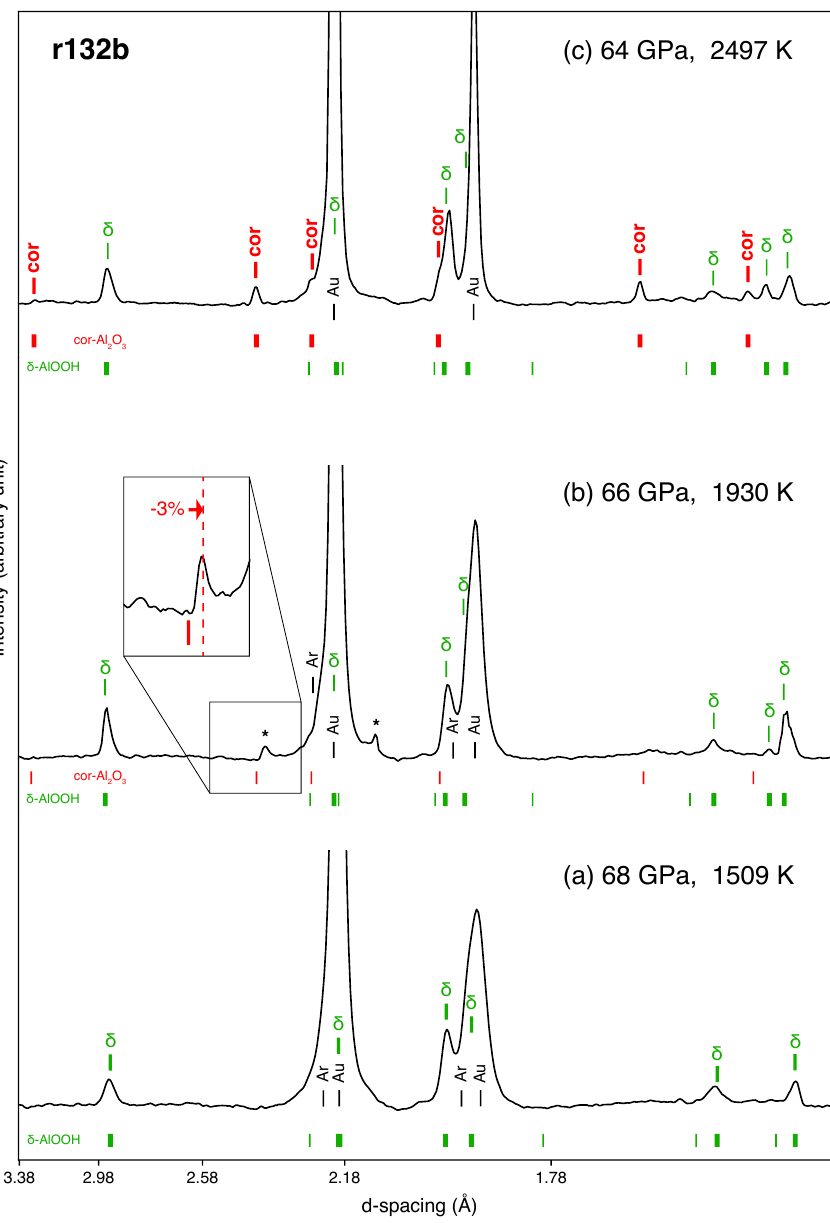
Figure 1. Dehydration of δ -AlOOH detected in XRD patterns for run#132b. ( a ) At 1509 K, only precursor materials (i.e., δ -AlOOH, Ar and Au) are present; ( b ) At 1930 K, two unknown peaks appear, one of which could belong to cor-Al 2 O 3 . However, as the inset shows, the unit-cell volume of cor-Al 2 O 3 would have to be 3% smaller than that expected at the P - T conditions. ( c ) At 2497 K, where dehydration of δ -AlOOH to cor-Al 2 O 3 occurs, peaks belonging to the later can be clearly seen. The stars ( ∗ ) denote unidentified lines appearing during heating. The calculated peak positions for the phases are shown as vertical ticks with different colors. The thick ticks refer to identified peaks, while thin ticks are calculated peak positions for which identification was less robust (likely due to their intrinsically low diffraction intensities). X-ray energy was 30